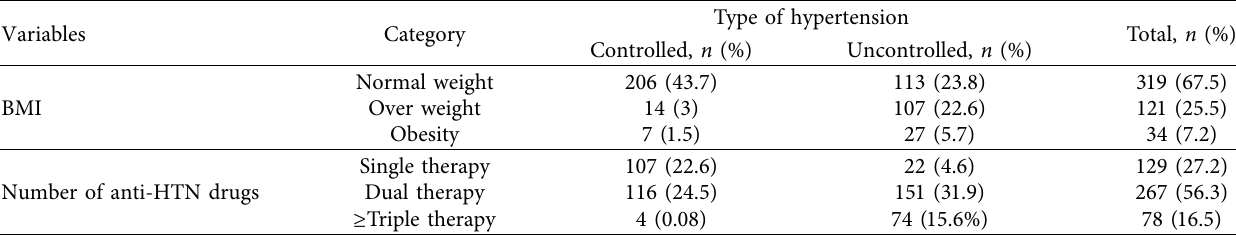
Table 3: Description of body mass index and the number of antihypertensive drugs taken among adult hypertensive patients at St. Paul’s